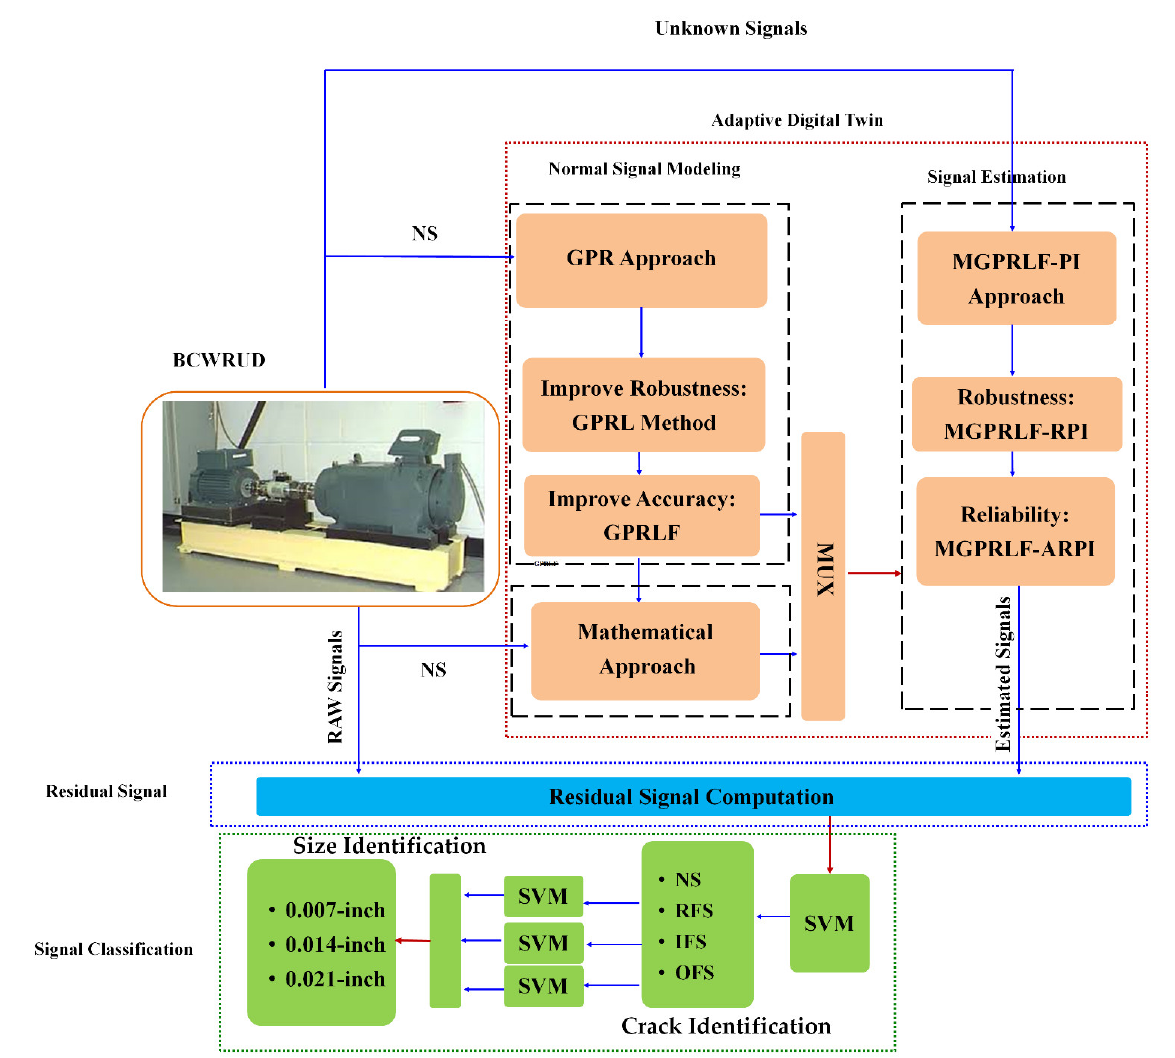
Figure 2. The combination of proposed adaptive digital twin and machine learning for the bearing crack detection and size identification.